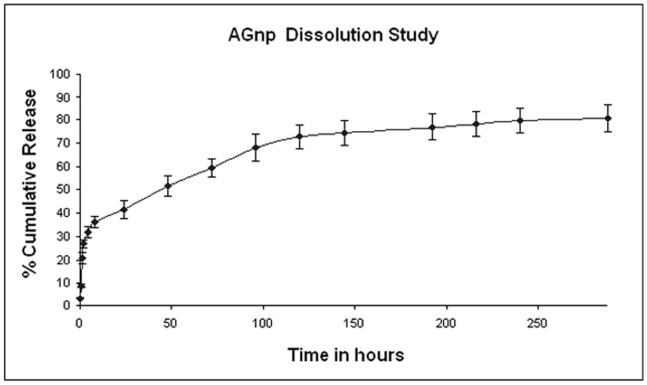

In vitro release profile of AGnp preparation.Results expressed as mean ± S.D. (n = 3). The time dependent in vitro release of AG was studied and the average percentage cumulative release over time was plotted. The release responses for AGnp preparation was biphasic in nature. A rapid release of AG occurred up to 96 hours followed by a sustained release over a period of 288 hours. The release however, was steady in later hours which continued for a prolonged period of 288 hours.